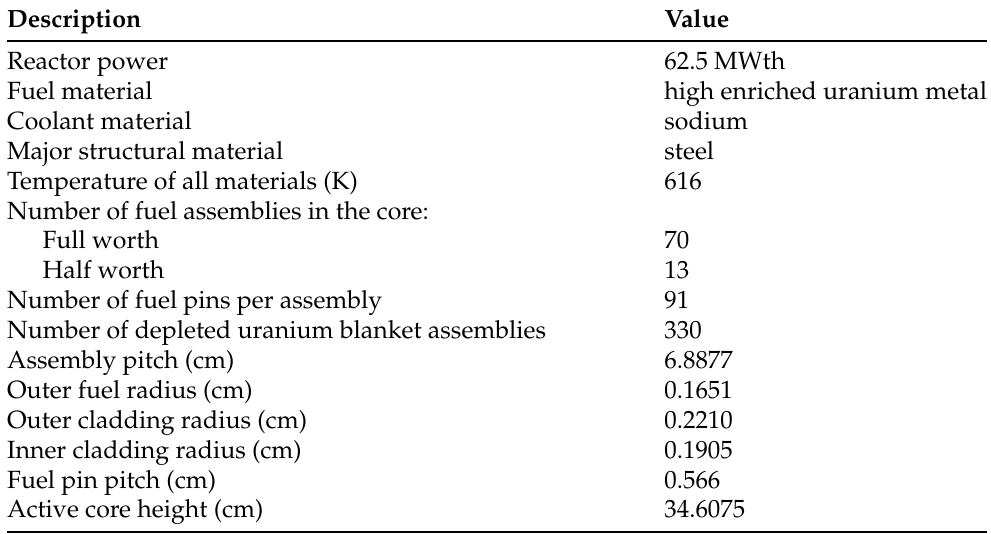
Table 1. Key characteristics of EBR-II